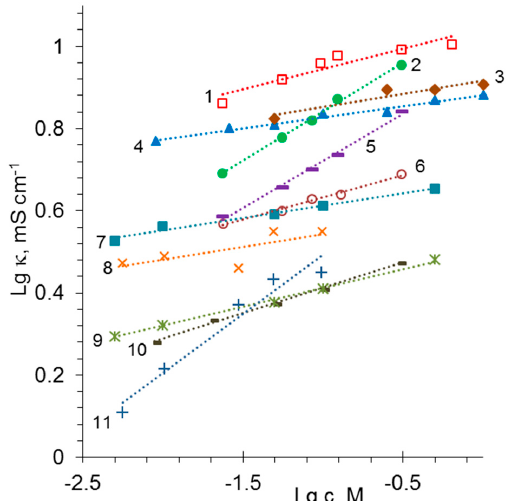
Figure 4. Conductivity of IEMs under AC ( κ ) as a function of bathing solution concentration, c , in Lg-Lg coordinates for different membranes; 1 – CMX in KCl [141], 2 – MK-40 in KCl [141], 3 –